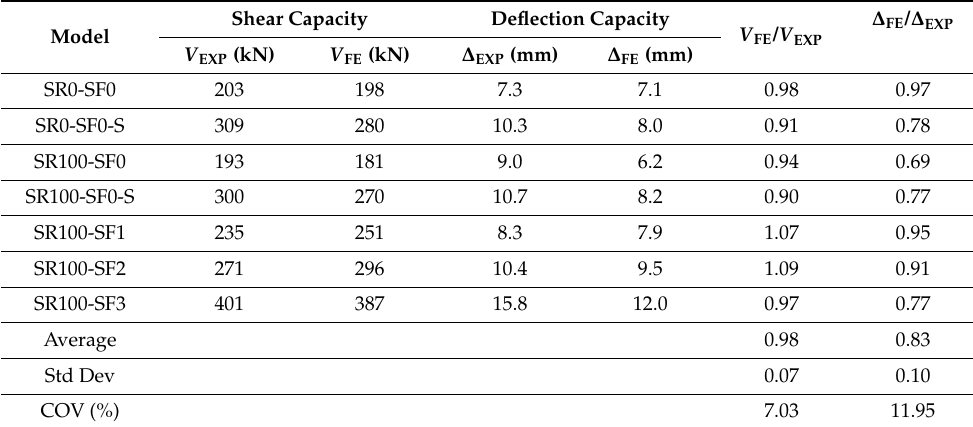
Figure 8. Numerical and experimental responses of group S: ( a ) SR0-SF0; ( b ) SR0-SF0-S; ( c ) SR100-SF0; ( d ) SR100-SF0-S; ( e ) SR100-SF1; ( f ) SR100-SF2; and ( g ) SR100-SF3. Table 3. Comparison between numerical and experimental results of group S.